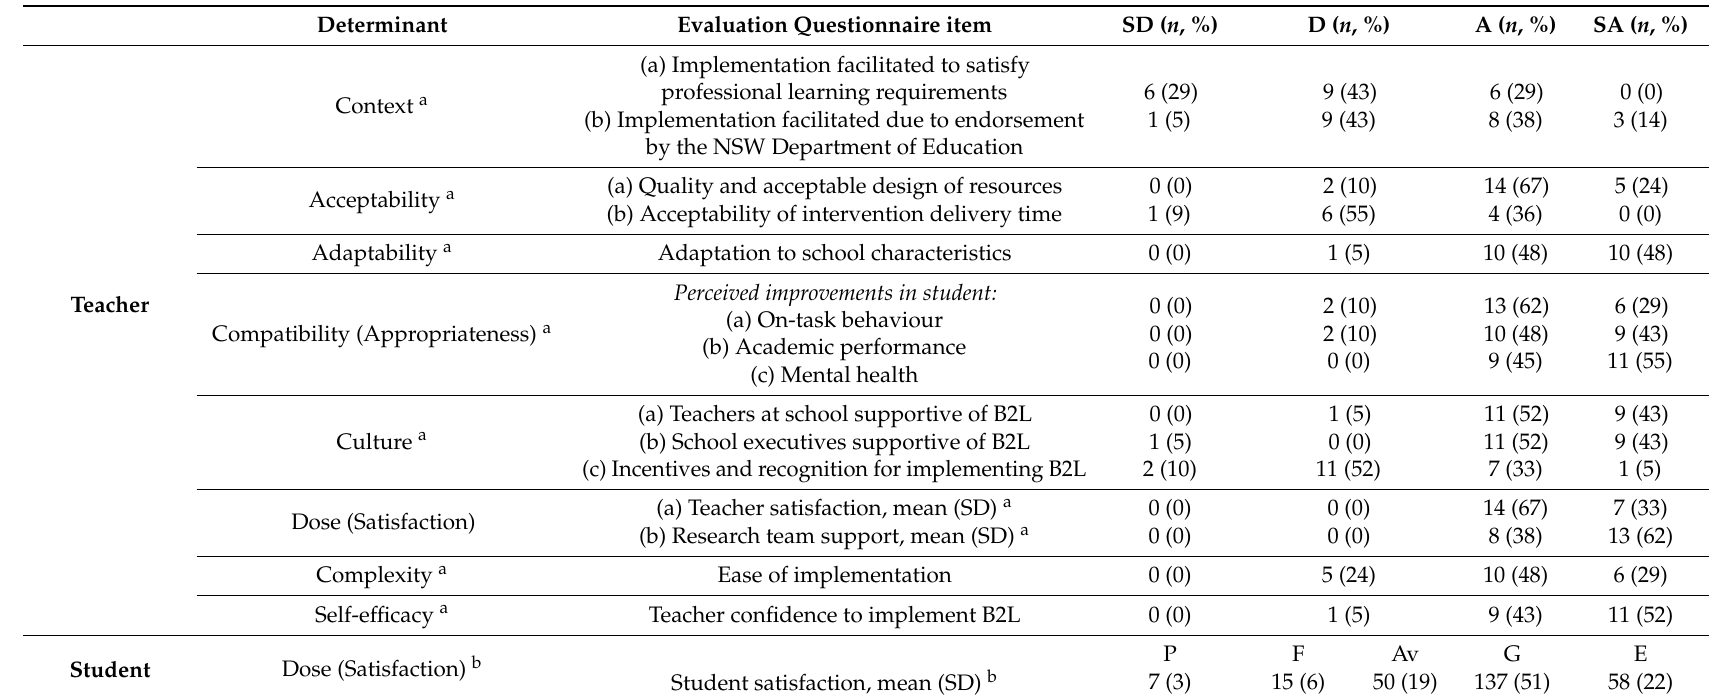
Table 5. Frequencies of reported implementation